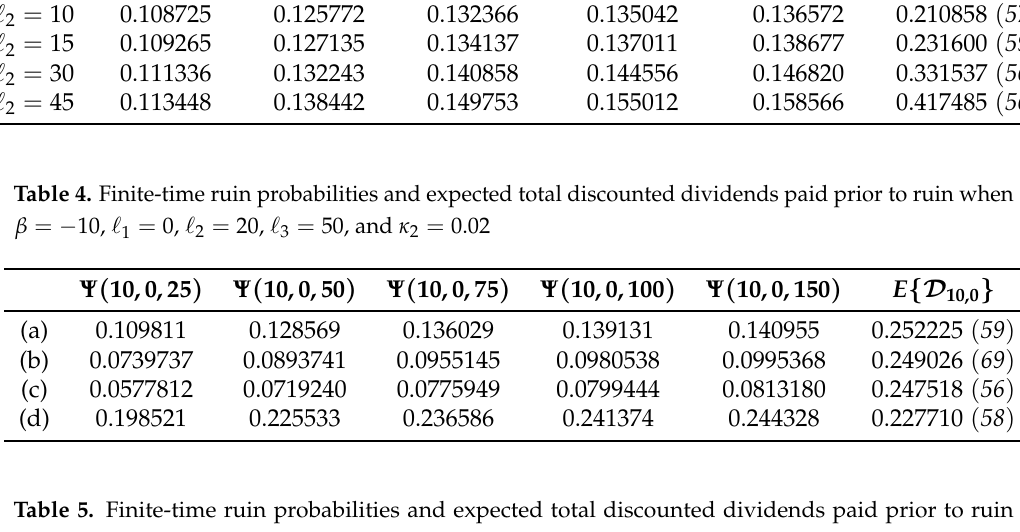
Table 5. Finite-time ruin probabilities and expected total discounted dividends paid prior to